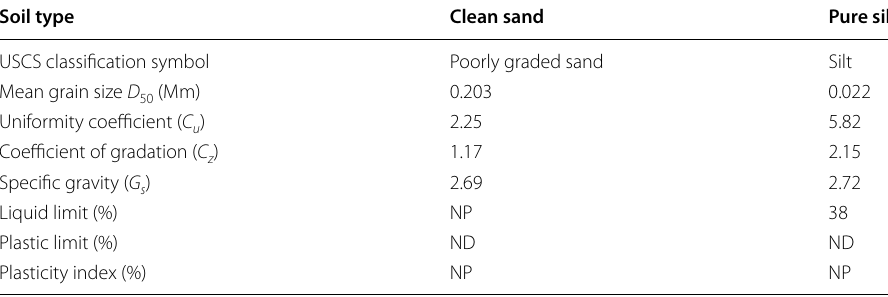
NP non-plastic, ND not determinable